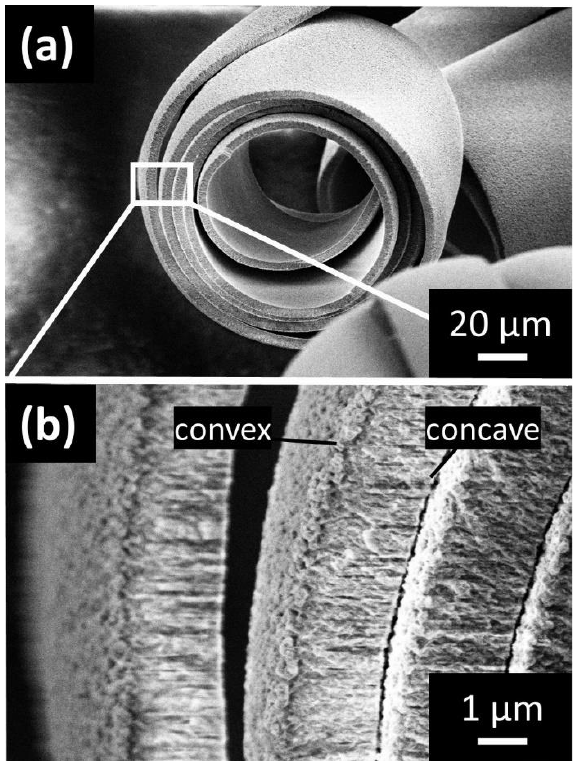
Figure 3. Scanning electron micrograph (SEM) images of Co(OH) 2 /PSS microscrolls. ( a ) Homoge- nously rolled microscroll with five twists and exposed cross-section. ( b ) Magnified view of the cross- section revealing a nanogranular substructure and a bifurcated arrangement separating the individ- ual layers of the spiral into two distinct domains comprising less-ordered nanostructural motifs near the convex surface of the film and well-ordered pillar-like features near the concave surface.